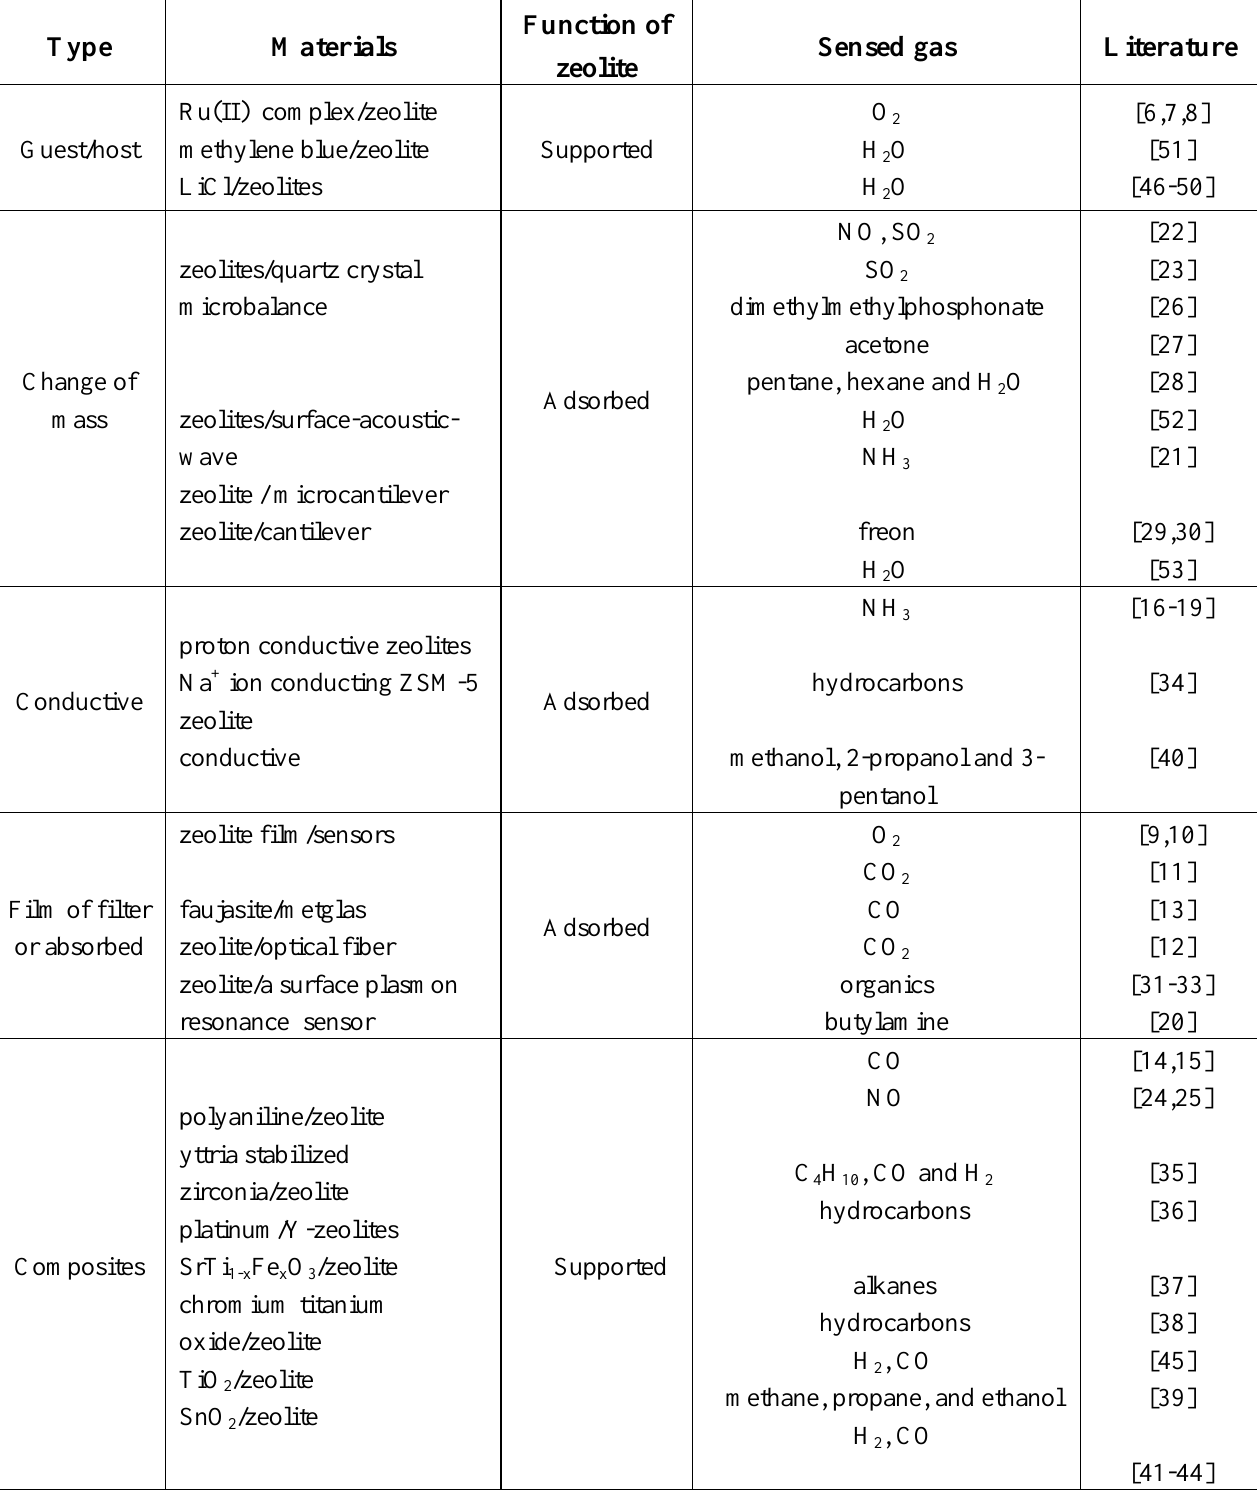
Table 1. Types of zeolite-based materials for gas